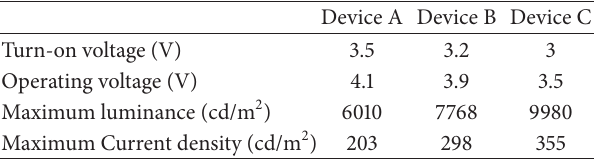
Table 1: Various characteristics of devices